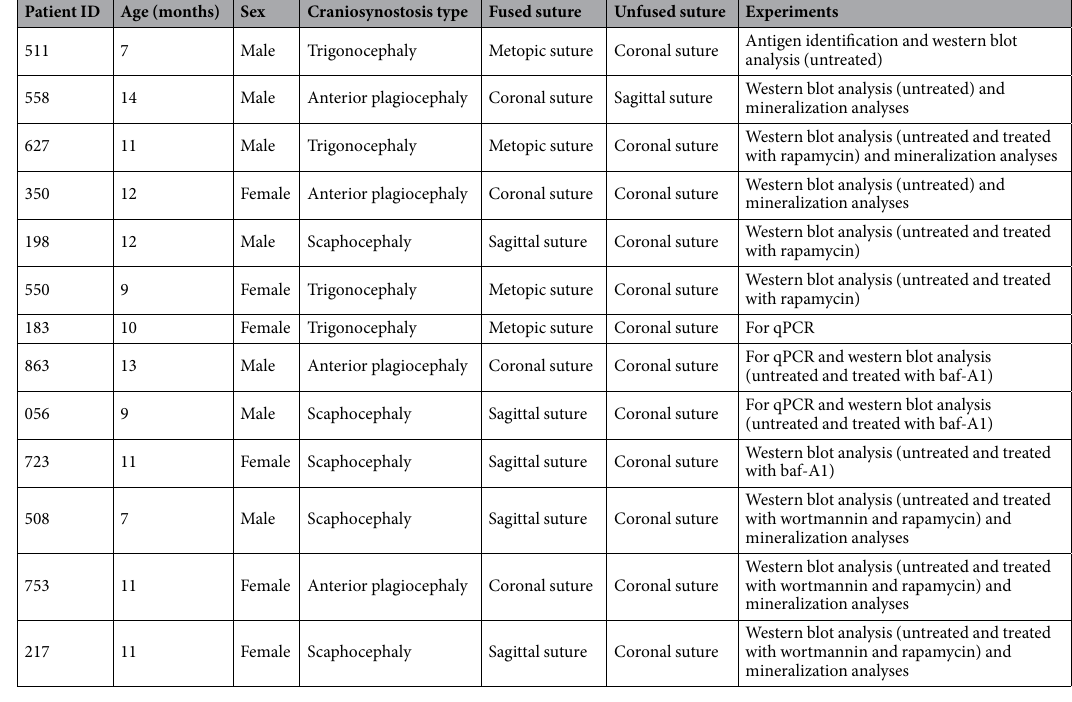
Table 1. Patients and